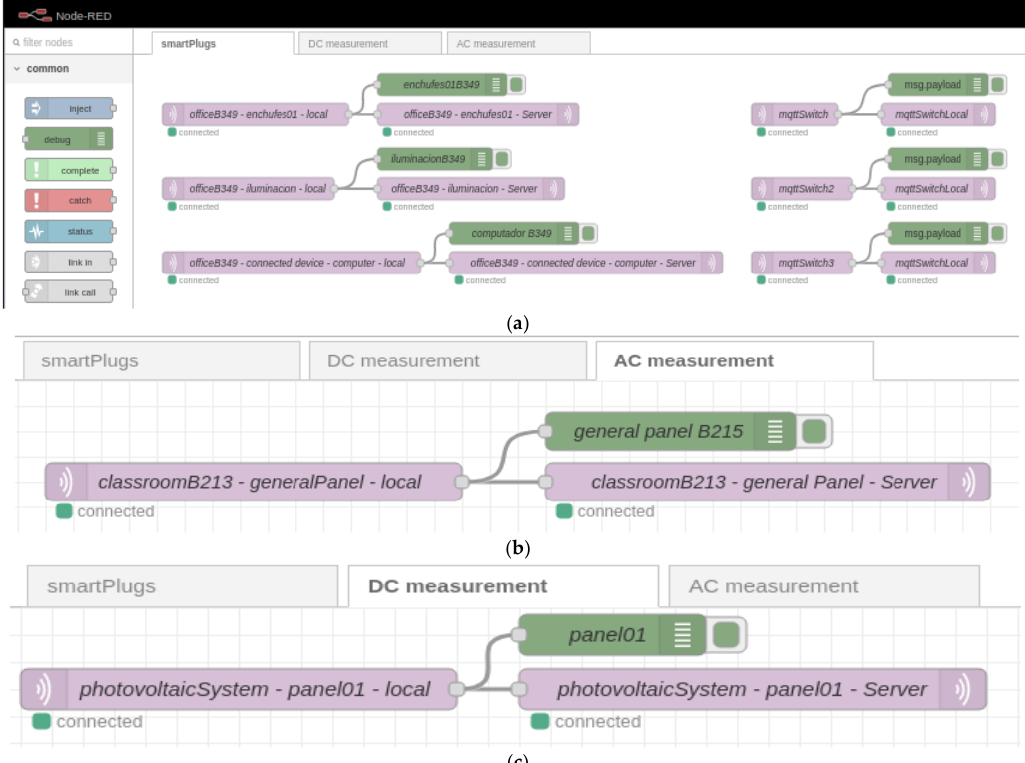
Figure 7. Node-RED configuration for forwarding data received from different devices ( a ) smart plugs ; ( b ) general energy measurement; ( c ) direct current measurement.